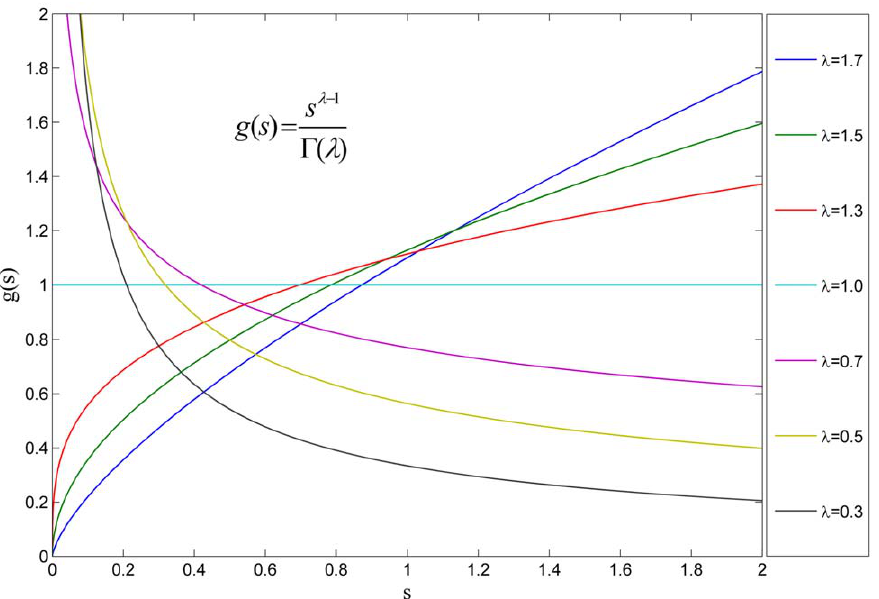
Figure 1. Graph of the weighting function g ( s ) with intermediate values of l . With 0 v l v 1 , the curves demonstrate the property of fading memory, while in the case where l w 1 , the memory of earlier time is enhanced while recent values of g ( s ) are attenuated.